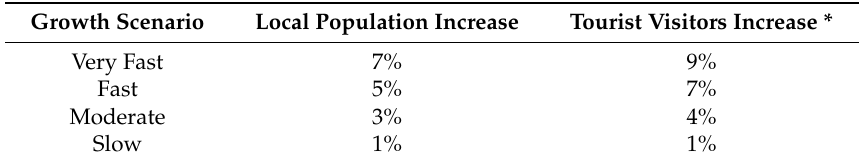
Table 5. Annual population and tourist growth scenarios used for water demand